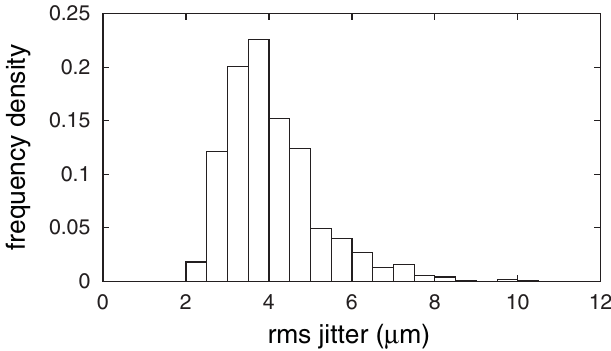
FIG. 7. Distribution of rms extraction jitter, for 1000 seeds of random injection